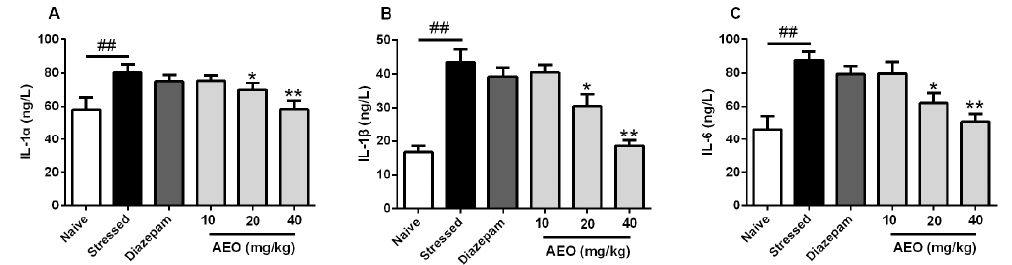
Figure 6. Effects of AEO on the levels of ( A ) interleukin 1 α (IL-1 α ), ( B ) IL-1 β , and ( C ) IL-6 in the serum of restraint stress-induced mice. Each value represents mean ± SEM with n = 8, ## p < 0.01 vs. the naive group, * p < 0.05 and ** p < 0.01 vs. the stressed group.